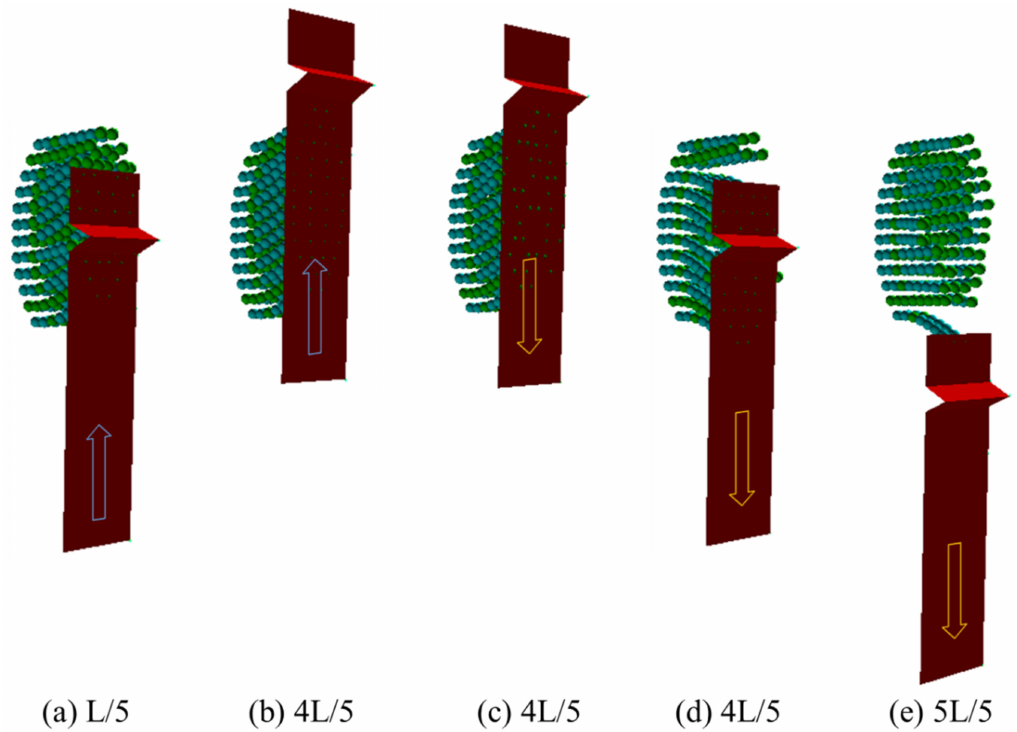
Figure 6. Dynamic behavior of toothbrush at the given positions in the case of d z = r and V = 0.05 m/s